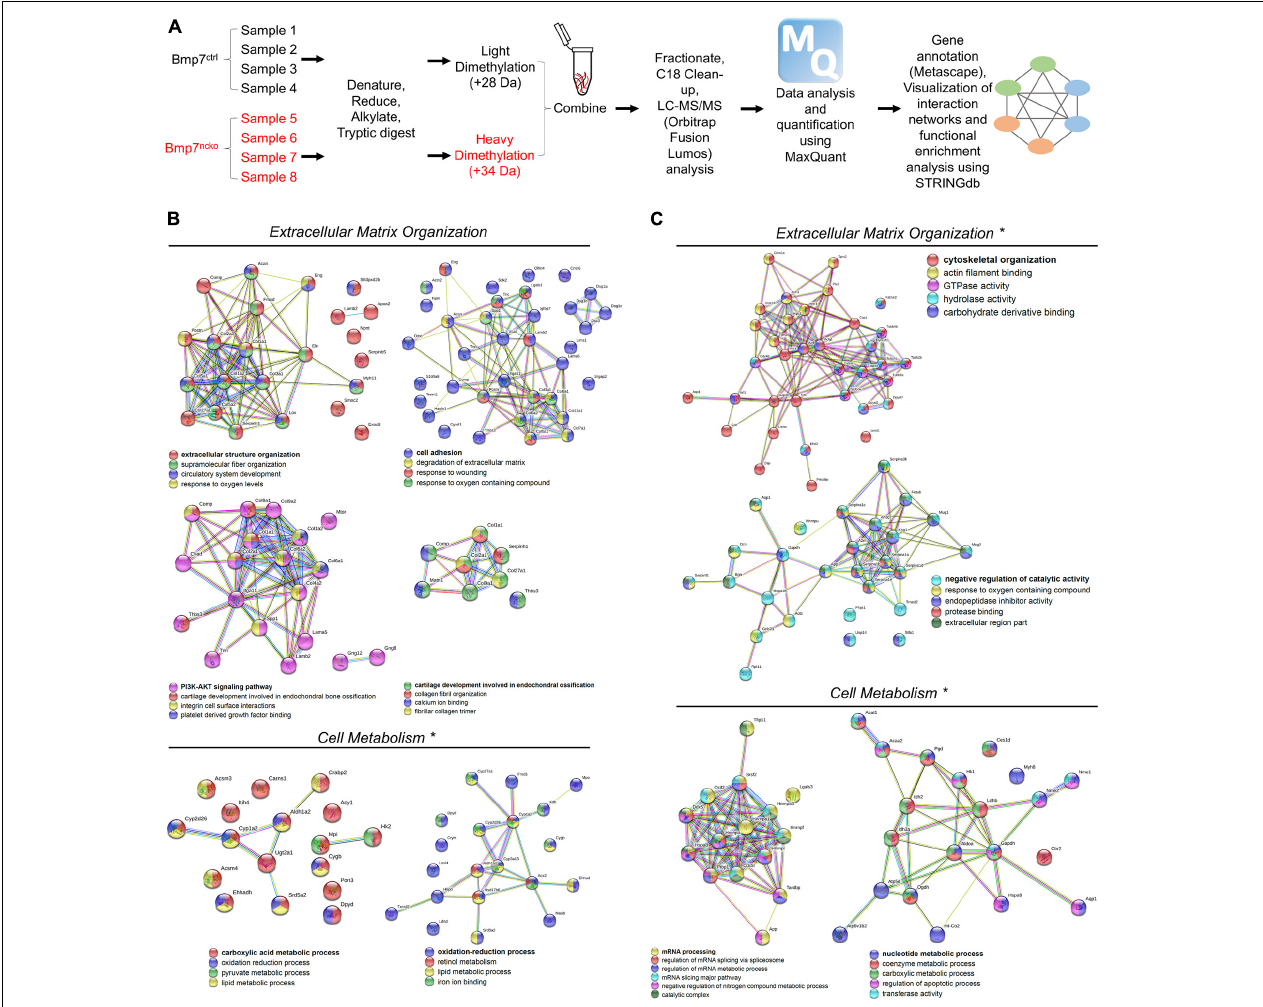
FIGURE 3 | Altered extracellular matrix (ECM) organization and cell metabolism precede nasal septum deviation in Bmp7 ncko mice. (A) Workflow of Proteomics experiment and analysis ( n = 4/age/genotype). STRINGdb software was used to identify protein-protein interactions. (B) Differentially expressed proteins and their associated biological processes altered in P14 Bmp7 ncko mice in comparison to Bmp7 ctrl . (C) Differentially expressed proteins and their associated biological processes altered in P30 Bmp7 ncko mice in comparison to Bmp7 ctrl . * Denotes proteins upregulated in Bmp7 ncko mice. Proteins involved in retinoic acid signaling and lipid metabolism were upregulated at 2 weeks whereas proteins involved in glucose metabolism were upregulated at 4 weeks. A list of all differentially regulated proteins is provided in the Supplementary Tables 1 , 2